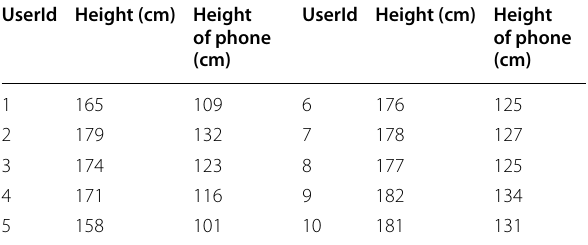
UserId Height (cm) Height